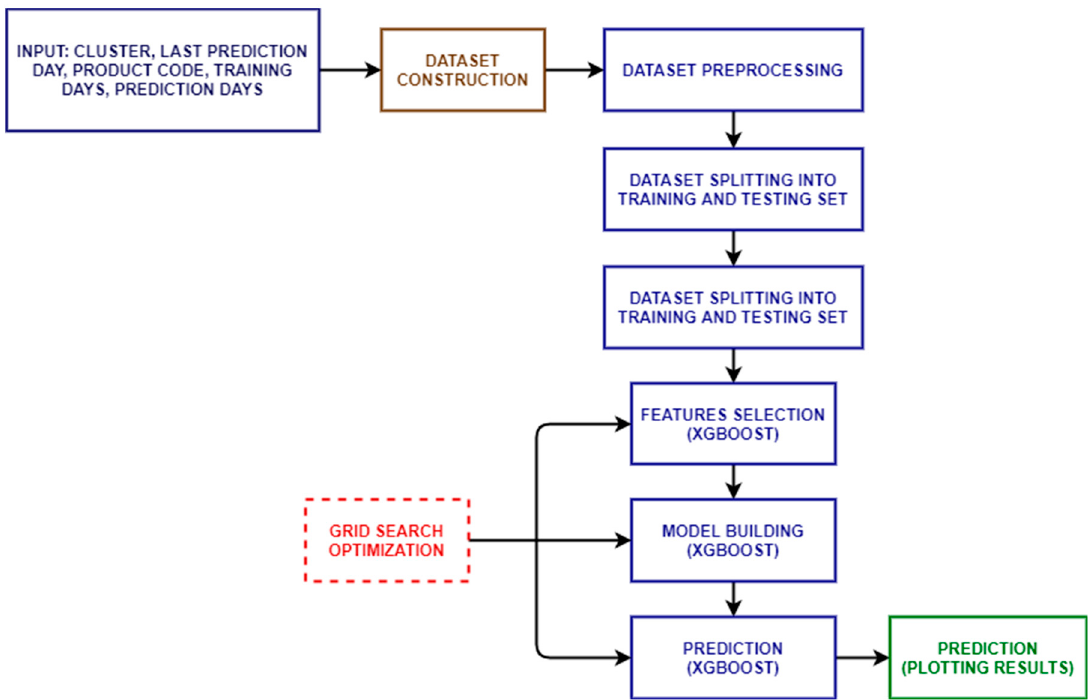
Figure 4. Flow chart of XGBoost algorithm for cluster sales forecasting.